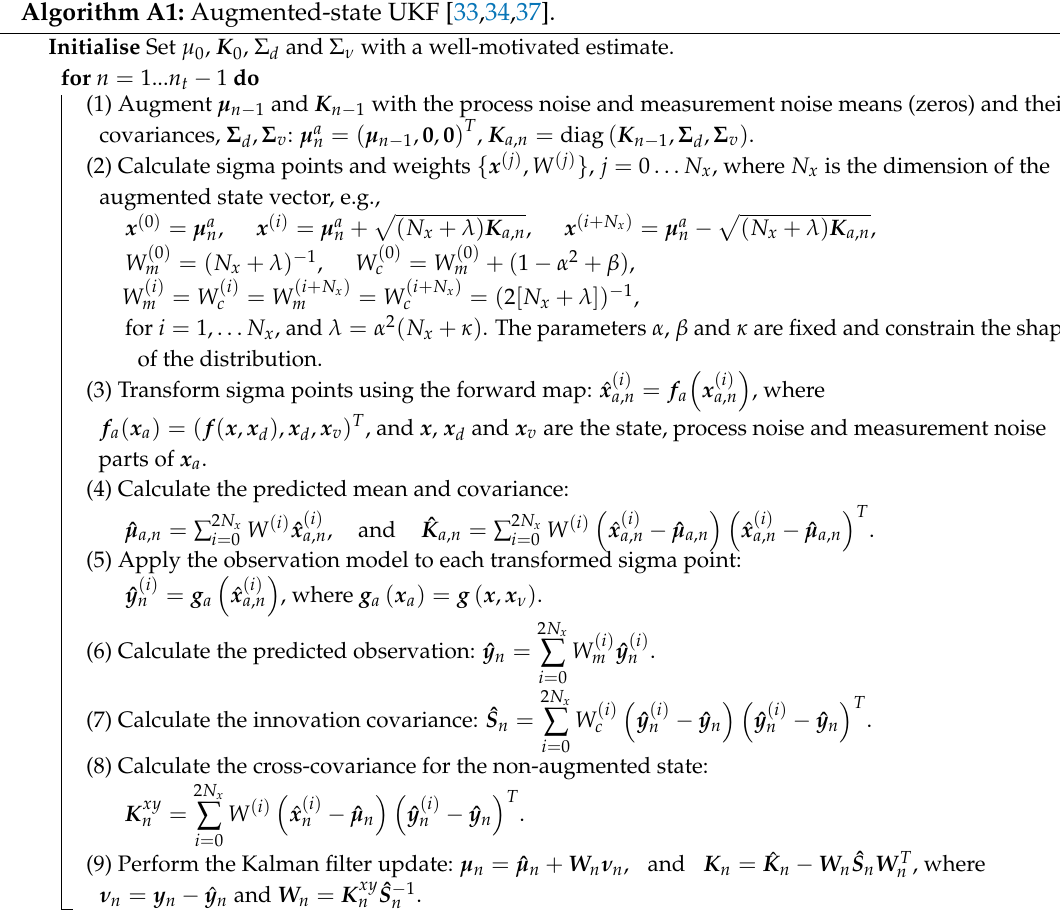
Algorithm A1: Augmented-state UKF